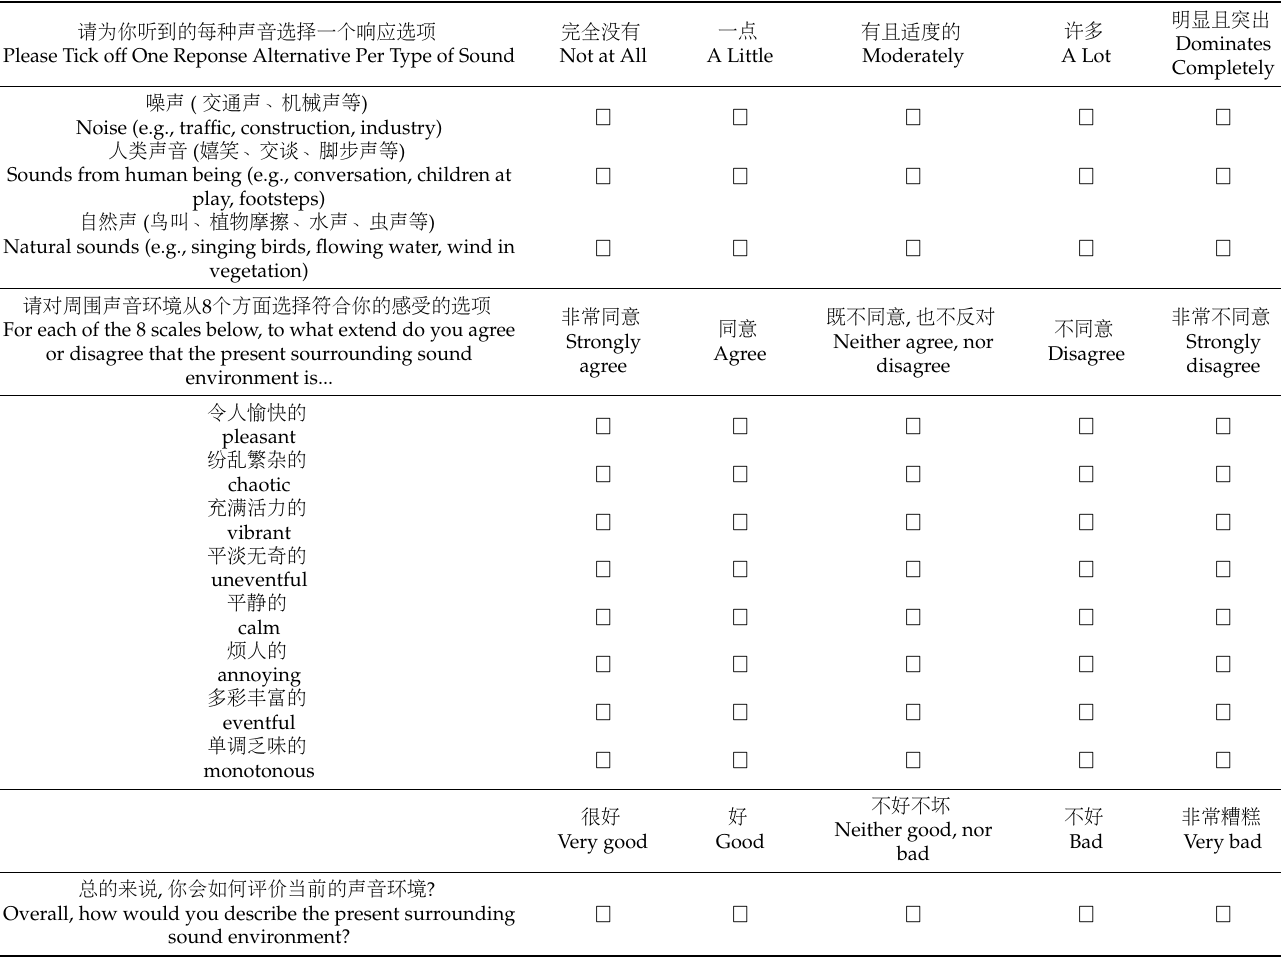
Table A2. Main contents of the soundwalk questionnaire (English and